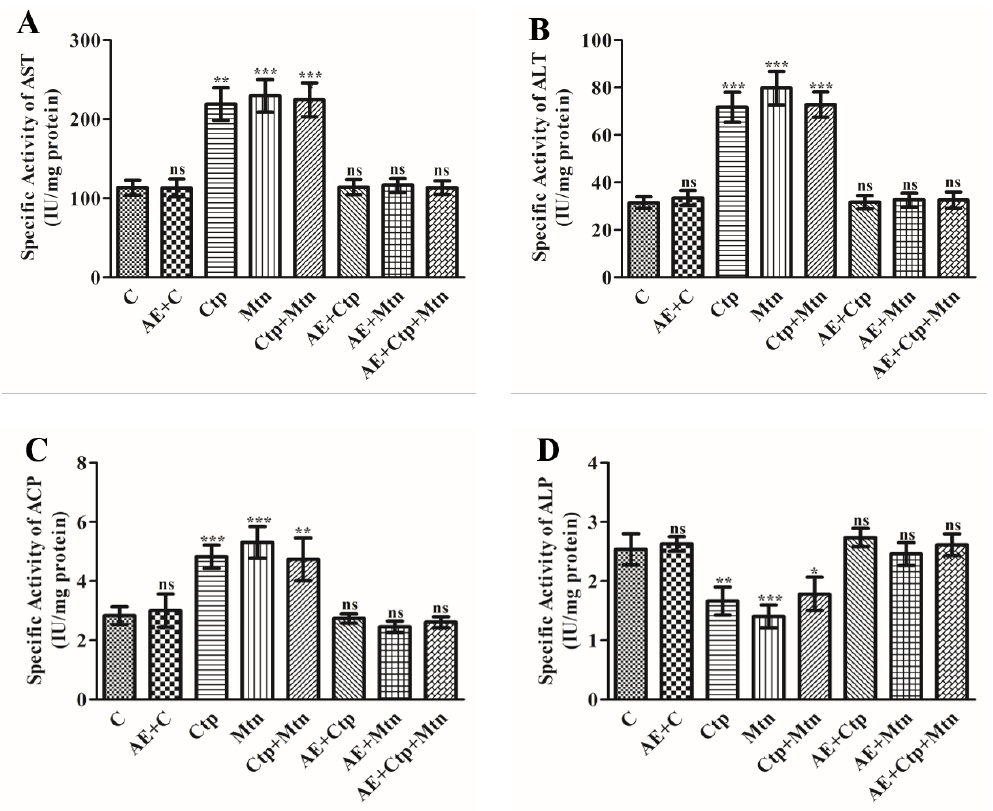
Figure 3. Effect of cartap and malathion as well as the aqueous extract of A. vera on the activity of transferases in rat blood serum. The activities of enzymes ( A ) AST, ( B ) ALT ( C ) ACP and ( D )